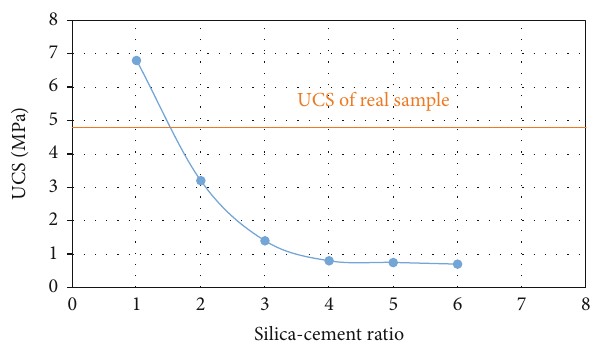
Figure 2: E ff ect of di ff erent silica/cement ratios on the UCS properties of corresponding arti fi cial